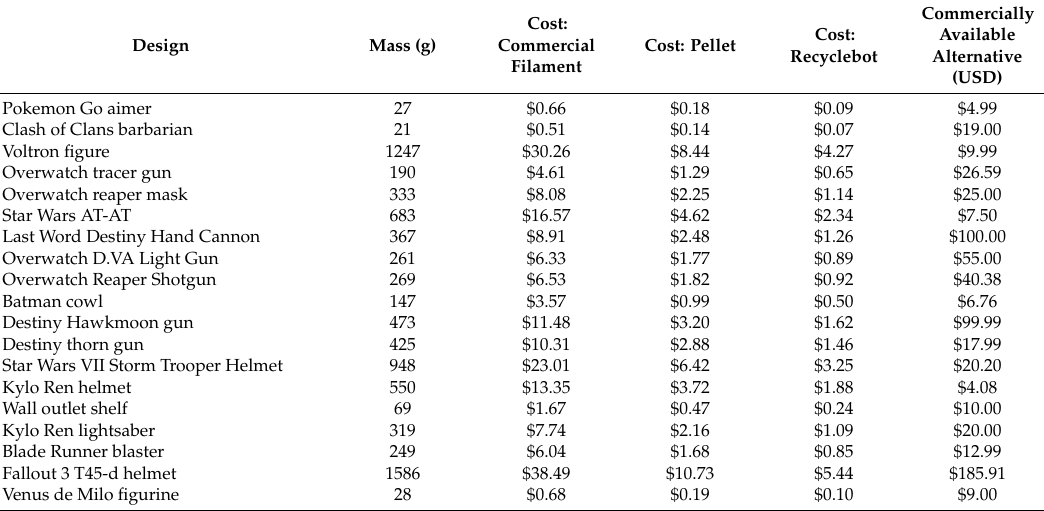
Table 2. Cost of producing toys and benchmark purchase price (US